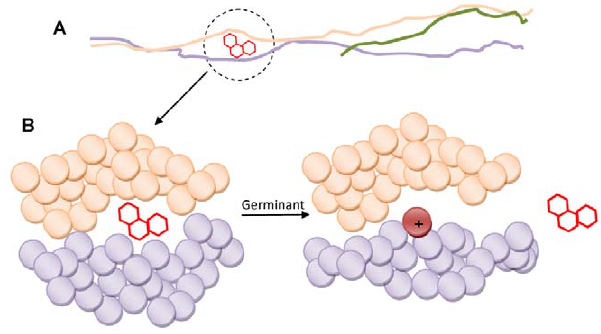
Figure 6. Schematic model of hydrophobic-hydrophilic transi- tions causing release of non-polar decorating fluorogenic molecules. The model shows how decorated coat proteins release a hydrophobic molecule by undergoing a germination-triggered hydro- phobic-hydrophilic conformational change. Amino acid residues are depicted as balls and molecular sizes are not to scale. Disulfide bonds are not shown for simplicity. A. Cross-linked coat proteins become decorated by non-covalent binding of a non-polar fluorogenic molecule within a hydrophobic domain. B. During germination, the domain undergoes conformational changes causing a hydrophobic-hydrophilic transition (e.g., appearance of positive charges) and concomitant release of the fluorogenic